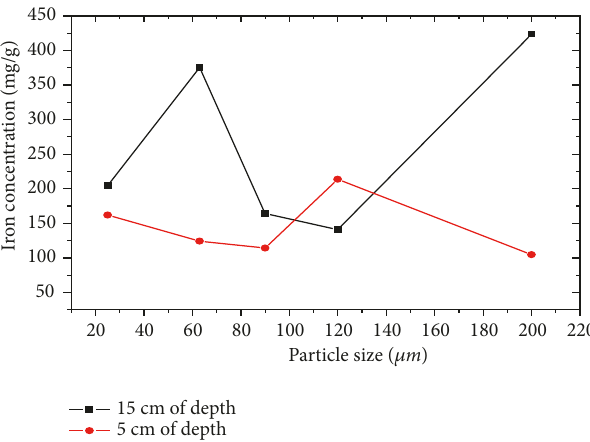
Figure 6: Evolution of iron concentration as a function of particle size and depth.